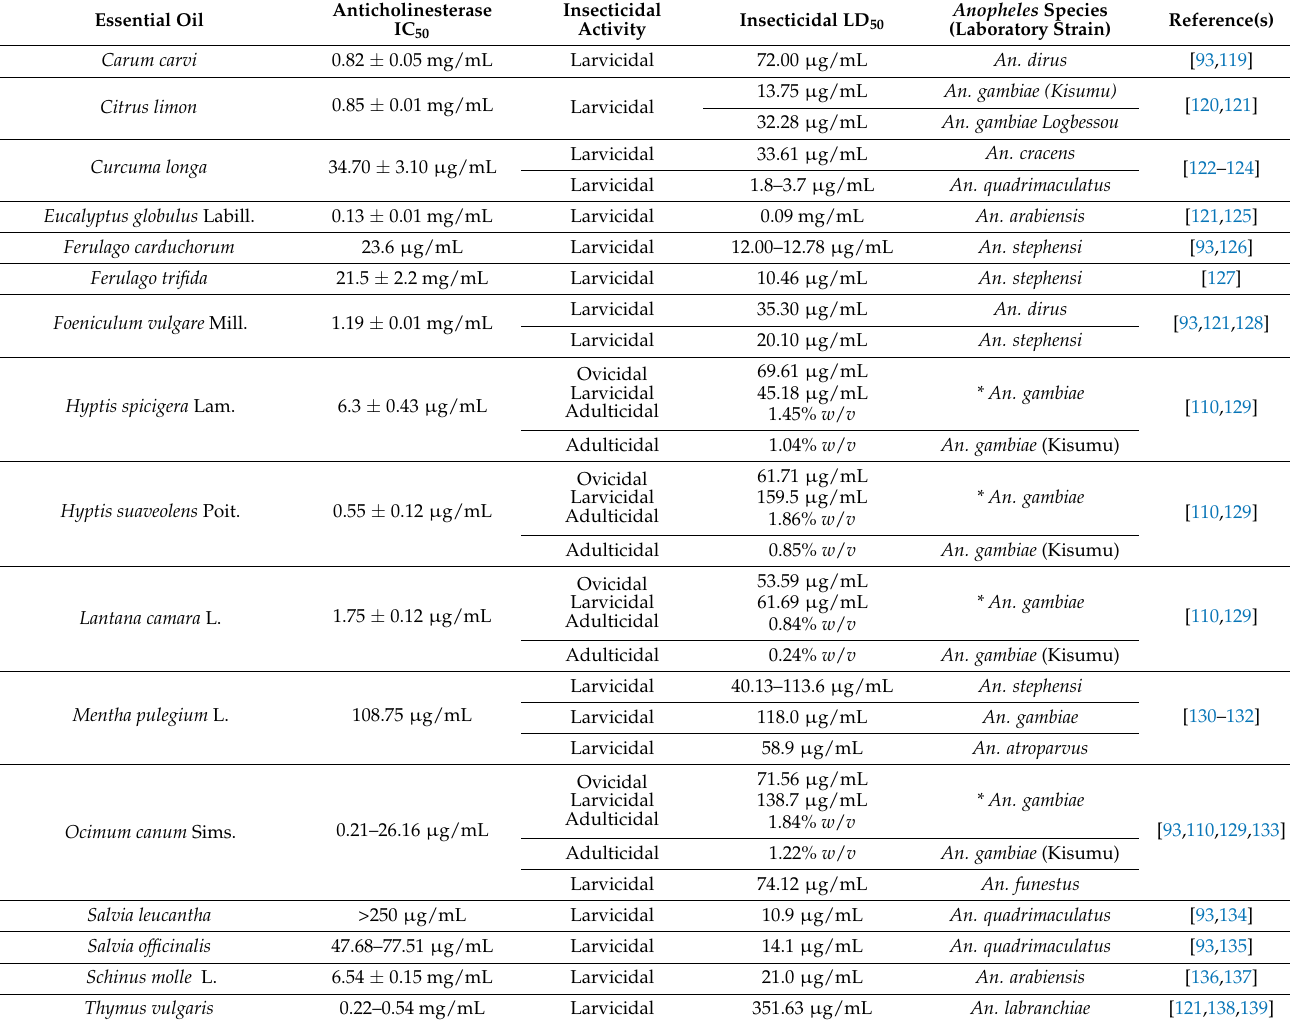
Table 1. Anticholinesterase and insecticidal activities of